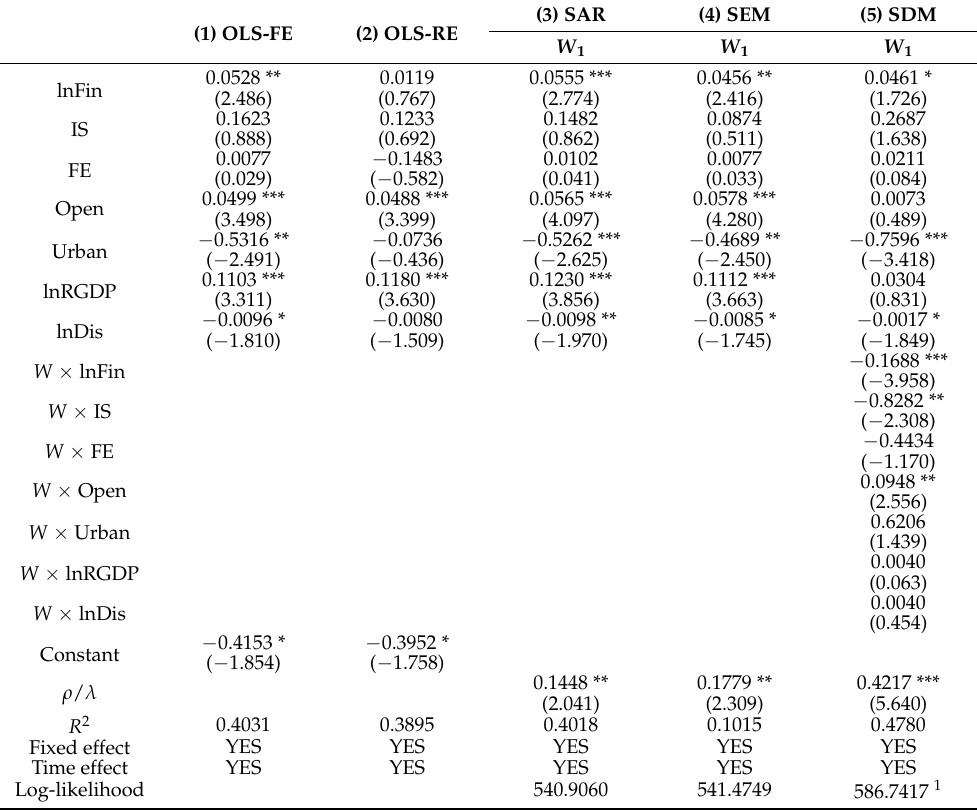
Table 8. The results of benchmark